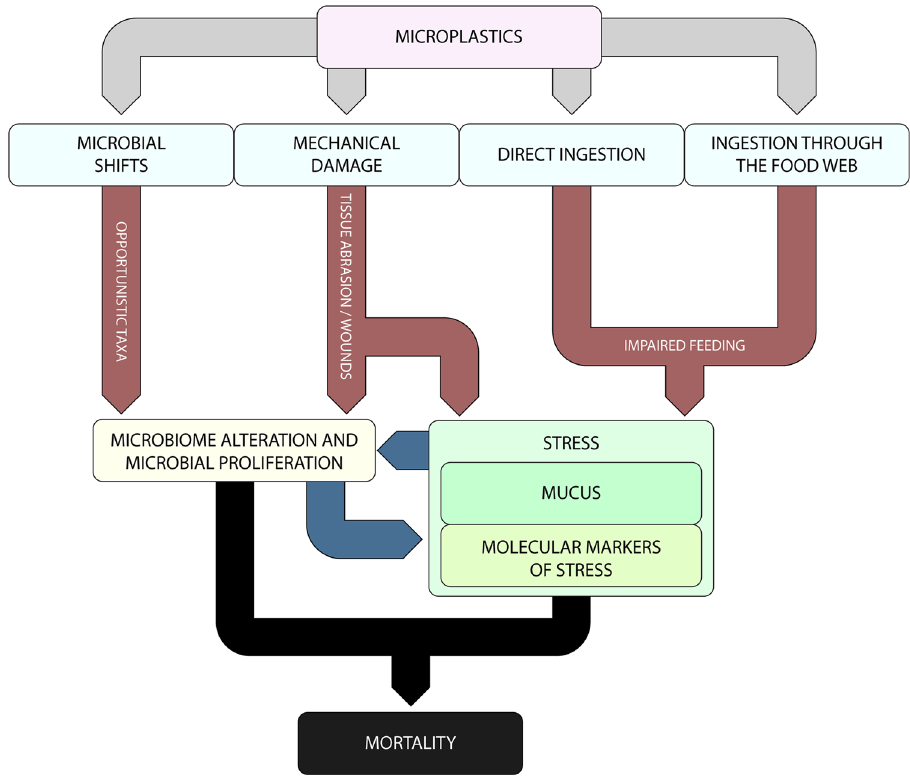
Fig. 7 Conceptual model of the multiple biological and physical impacts of microplastics on the red coral. Effects induced by ingestion, physical contact with coral tissue and microbial response to the presence of microplastic particles in the seawater. Reported are the consequent shifts in coral microbiome composition and stress in terms of changes in gene expression and DNA oxidative damage. The combination of all of these processes can ultimately cause coral